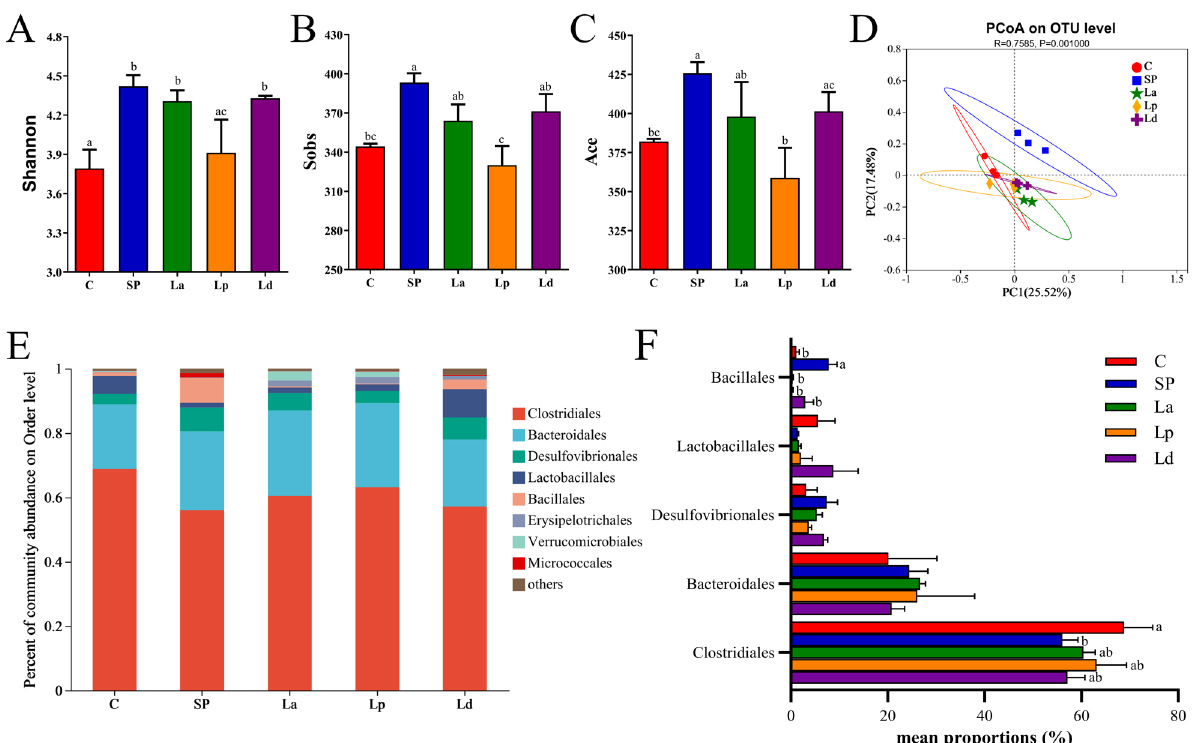
Figure 7. Lactobacillus modulates gut microbiota composition in soy-allergic mice. Diversity analysis of the gut microbiota of each group, including Sobs index ( A ), Shannon index ( B ), Ace index ( C ) and PCoA analysis ( D ). Gut microbial community composition ( E ) and inter-group differences in the top five abundances ( F ) at the Order level. Different letters denote statistically significant differences ( p < 0.05).